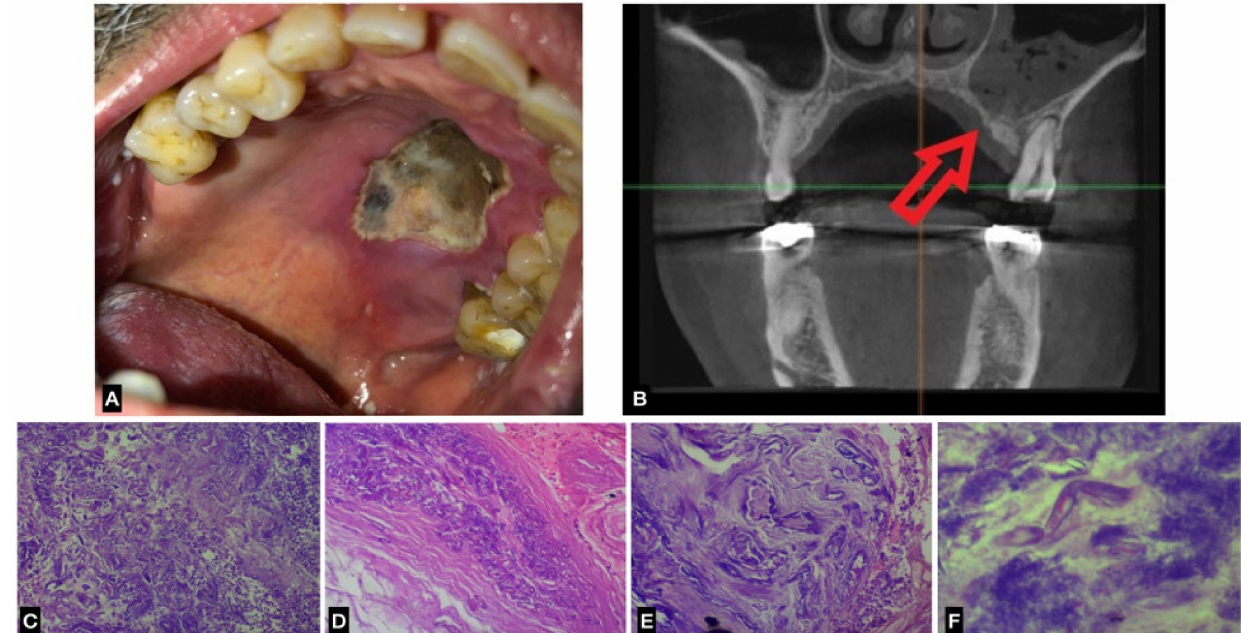
Figure 1. Case 1 with mucormycosis: ( A ) intra-oral photo shows the ulcerative and necrotic lesion in the left hard palate; ( B ) Cone-beam computed tomography (CBCT) in a coronal view showing opacification of the maxillary sinus, and irregular destruction of the palate (red arrow) and alveolar cortices on the left side. ( C – F ) Histological findings show a microphotograph of a ribbon-like organism with hyphae bent at a right-angle using H and E staining.